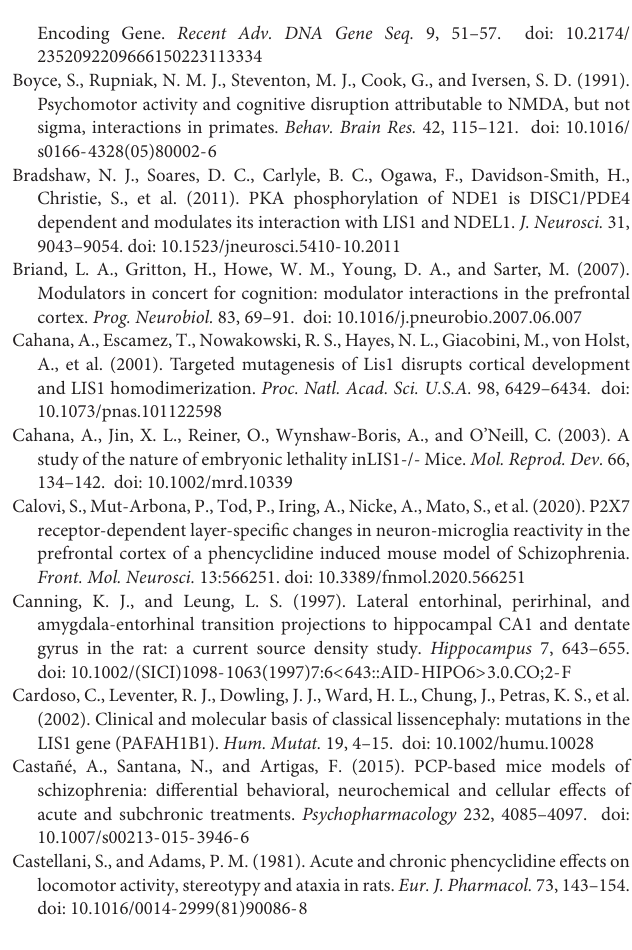
Supplementary Figure 1 | Genotyping by PCR of sLis1 (by using one set of primers). 0.1300 kb is the sLis1 band. Electrophoresis gel shows the molecular weight pattern, a positive control, a negative control and a representative example of an heterozygous